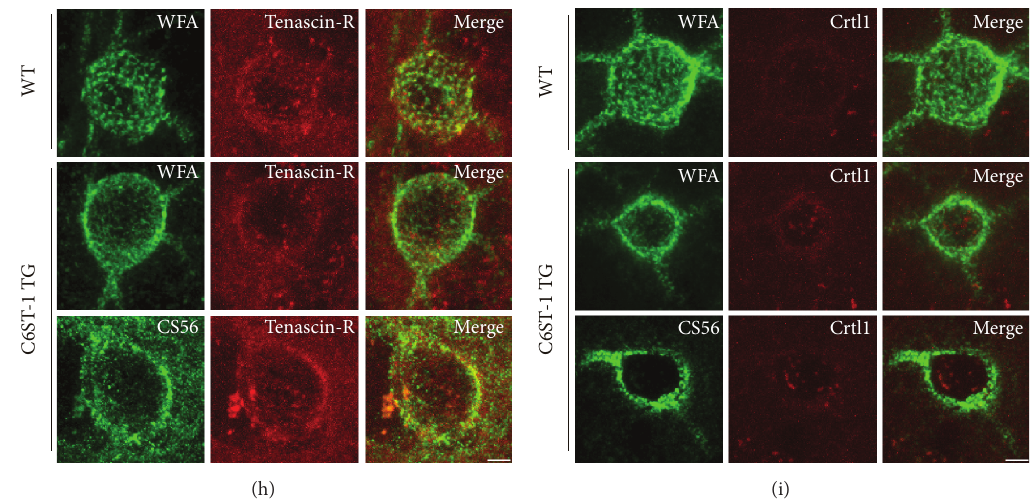
Figure 5: Impaired condensation of aggrecan into PNNs by overexpression of 6-sulfation. ((a), (b)) In 6-month-old adult WT mice, aggrecan showed a well-formed meshwork, which is similar to WFA lectin staining. (b) Magnification of boxed regions in (a). ((c)–(e)) In age-matched C6ST-1 TG mice, WFA-positive PNNs showed marked condensation of aggrecan, whereas neighboring CS56-positive PNNs showed diffuse and less condensed aggrecan staining. ((d), (e)) Magnification of boxed regions in (c). Immunolocalization of other PNN components including phosphacan (f), neurocan (g), tenascin-R (h), and Crtl1 (i) in WFA-positive and CS56-positive PNNs. In contrast to the impaired accumulation of aggrecan in CS56-positive PNNs in C6ST-1 TG mice, condensation of other PNN components was comparable between WT and C6ST-1 TG mice. Scale bars, 5 𝜇 m.